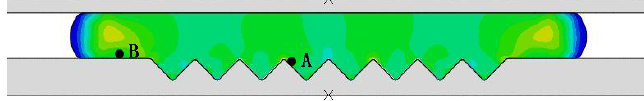
Figure 13. Two representative points of microstructures simulation [30].